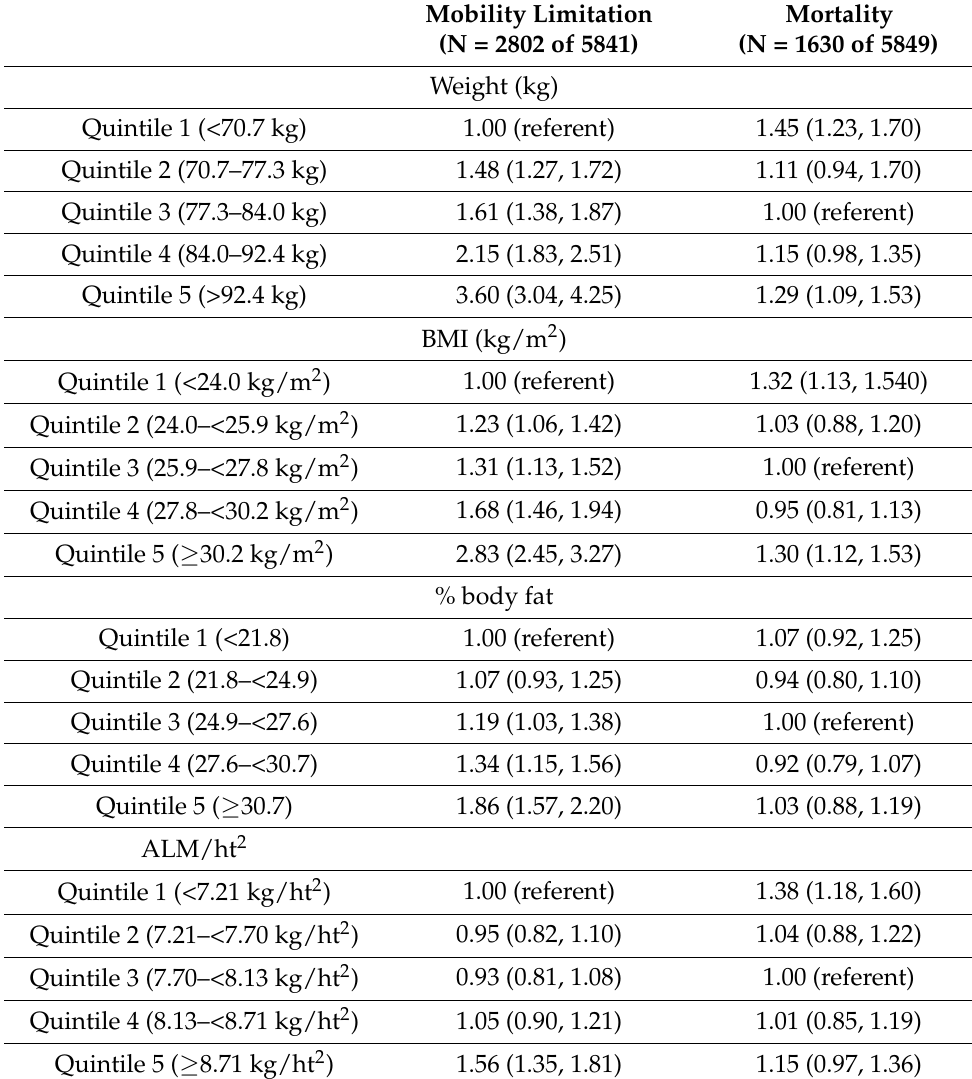
Table 2. The likelihood of self-reported mobility limitation over 14.4 years or the risk of mortality over 10 years by quintile of weight, BMI or percent fat at the baseline exam for MrOS